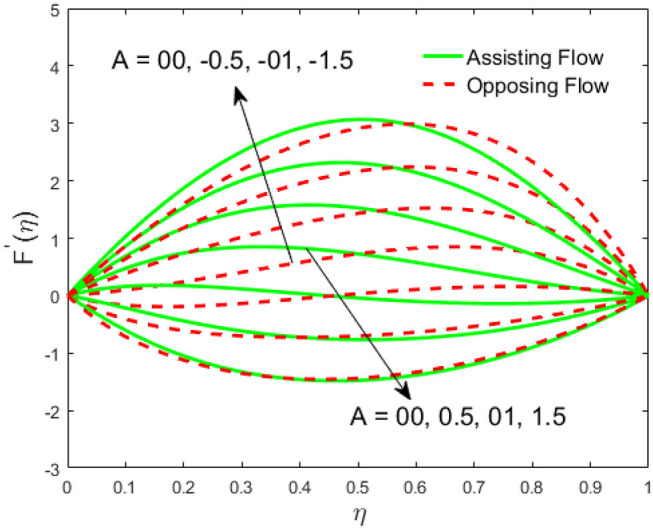
Impact of A on F′(η).